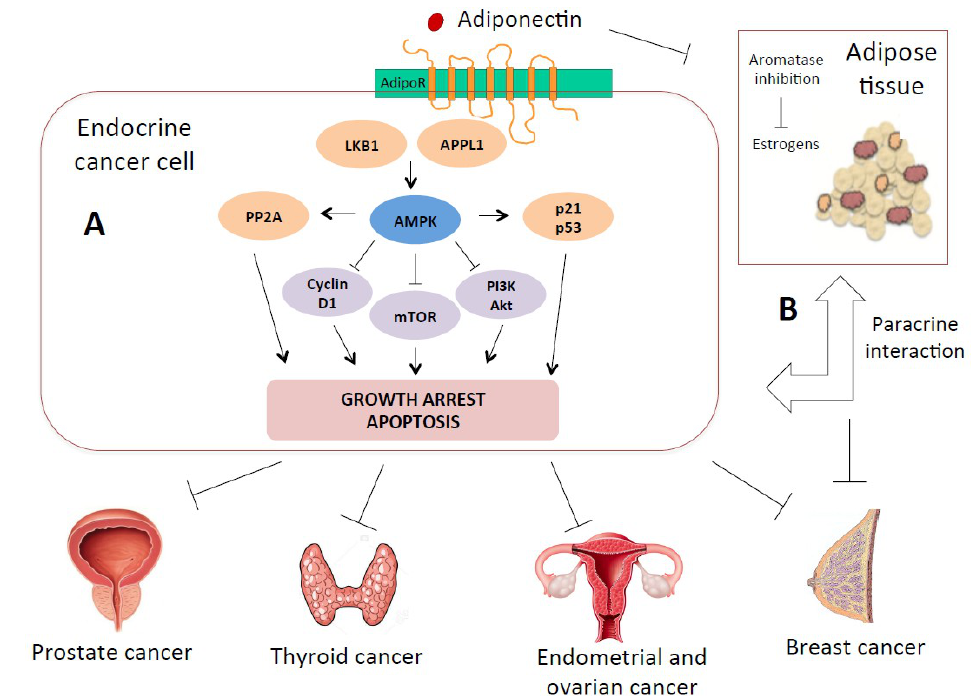
Figure 2. APN’s receptor-mediated and paracrine actions on endocrine cancer cells. ( A ) APN activates adenosine monophosphate-activated protein kinase (AMPK) via an increased expression of the adaptor protein APPL-1 as well as the Ser/Thr kinase LKB1. AMPK activation affects cell growth by inducing p53, p21 and phosphatase 2A (PP2A) expression. Down-regulation of the mammalian target of rapamycin (mTOR), PI3K/Akt and Cyclin D1 signaling is also implicated in the APN-mediated growth arrest and apoptosis; ( B ) In adipocytes, APN inhibits aromatase activity, lowering estrogen production and reducing ER α -stimulation in adjacent breast cancer cells. It negatively a ff ects pro-survival pathways.